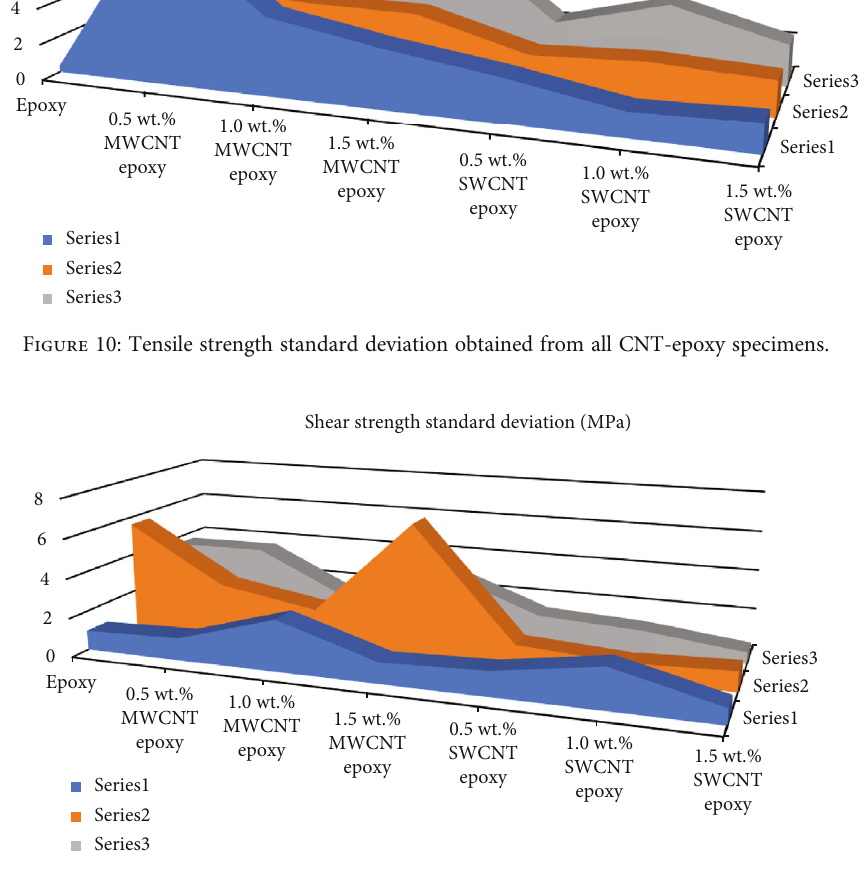
Figure 11: Shear strength standard deviation obtained from all CNT-epoxy specimens.